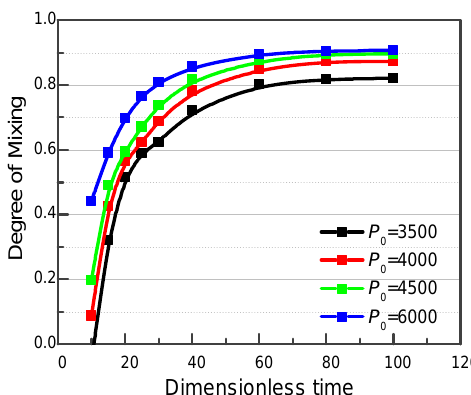
Figure 11. Degree of mixing in viscoelastic fluid case under modulated pressure at both inlets with different modulating frequencies.